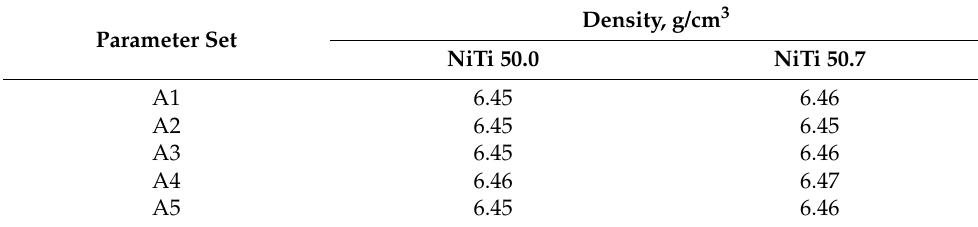
Table 4. Density of samples made by selective laser melting.